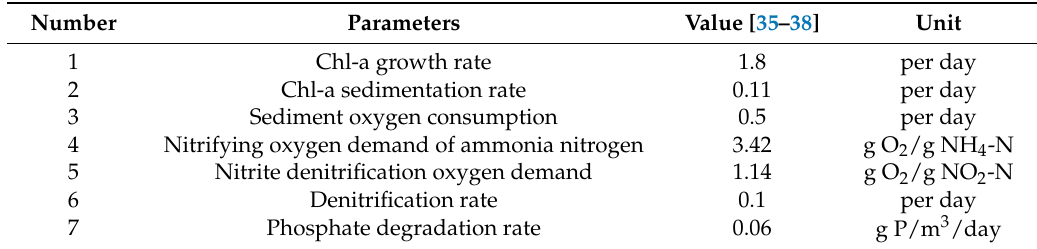
Table 2. Main water quality and eutrophication parameters.